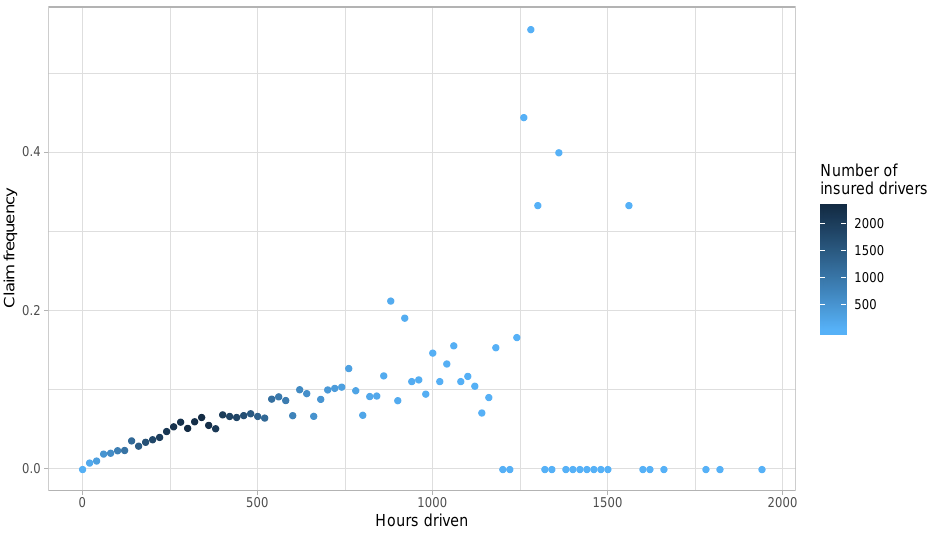
Figure 8. Claims Frequency vs. Hours